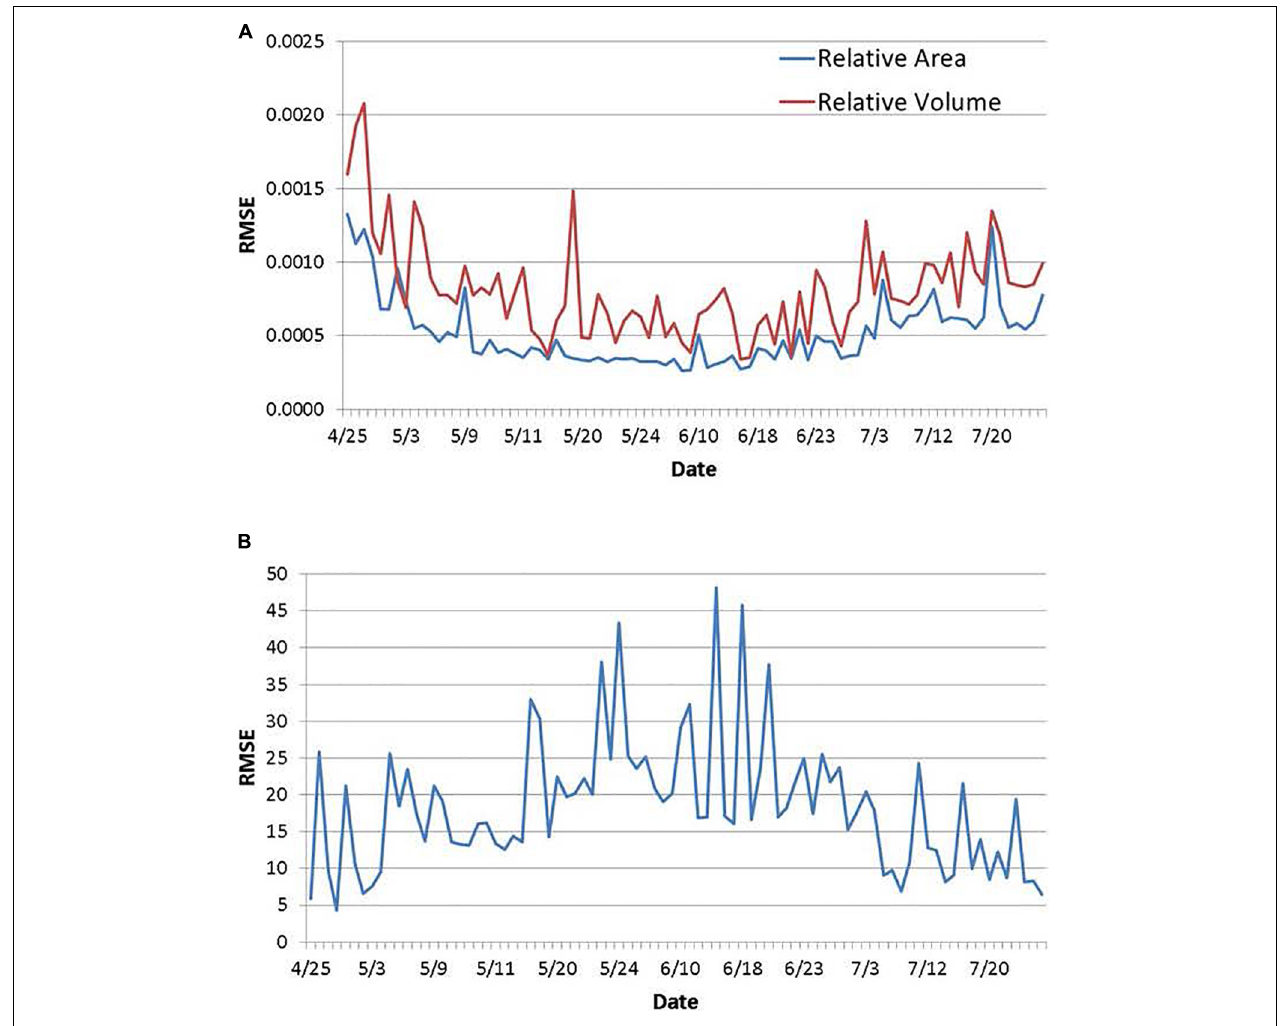
FIGURE 4 | RMSE of relative area and volume (as fractions, panel A ) and of oil volume (m 3 , panel B ) for the base case model simulation (using HYCOM-FSU) compared to remote sensing-based